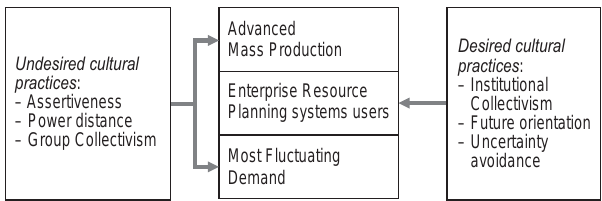
Fig. 1. Model of manufacturing strategies and choices in cultural